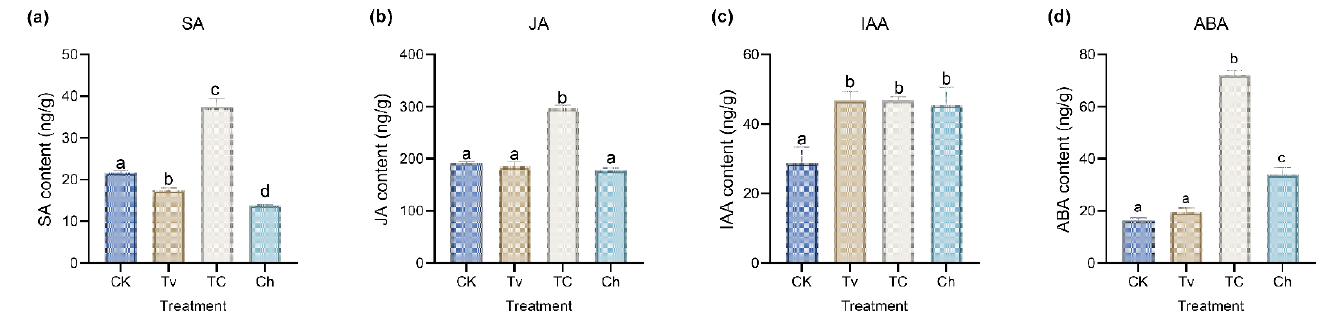
Figure 2. Phytohormone content of creeping bentgrass with T. virens treatment and/or inoculation of C. homoeocarpa at 19 dpi. ( a ) IAA. ( b ) ABA. ( c ) SA. ( d ) JA. Different letters aboved were used to indicate means that differ significantly ( p < 0.05).